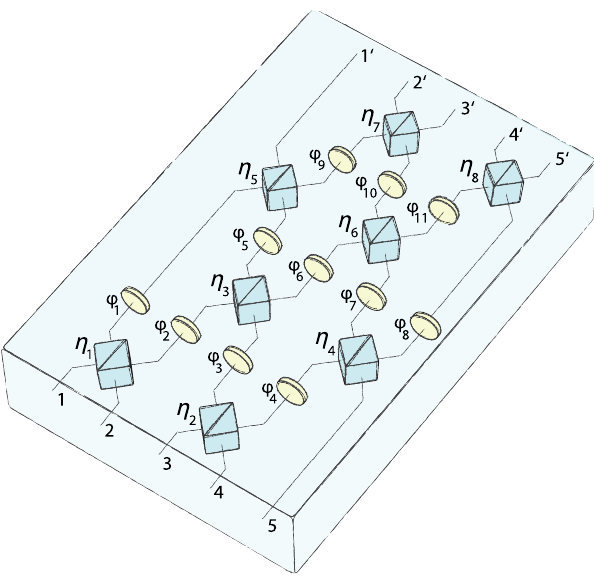
FIG. 7. Integrated photonic network. Schematic drawing of the optical network. The circuit consists of eight directional couplers ( η 1 ; … ; η 8 ), 11 phase shifters ( ϕ 1 ; … ; ϕ 11 ), five input modes ð 1 ; … ; 5 Þ , as well as five output modes ( 1 0 ; … ; 5 0 ). To allow coupling to the waveguide with standard fiber arrays, the input and output modes are separated 127 μ m and the total length of the chip is 10